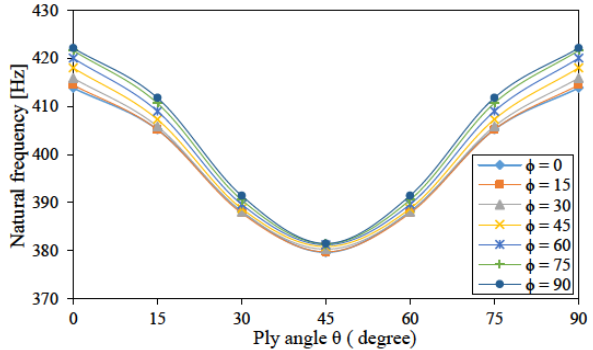
Figure 4: Natural frequency fiber orientation angle versus elliptical hole inclination (a/b = 0.5; BC =